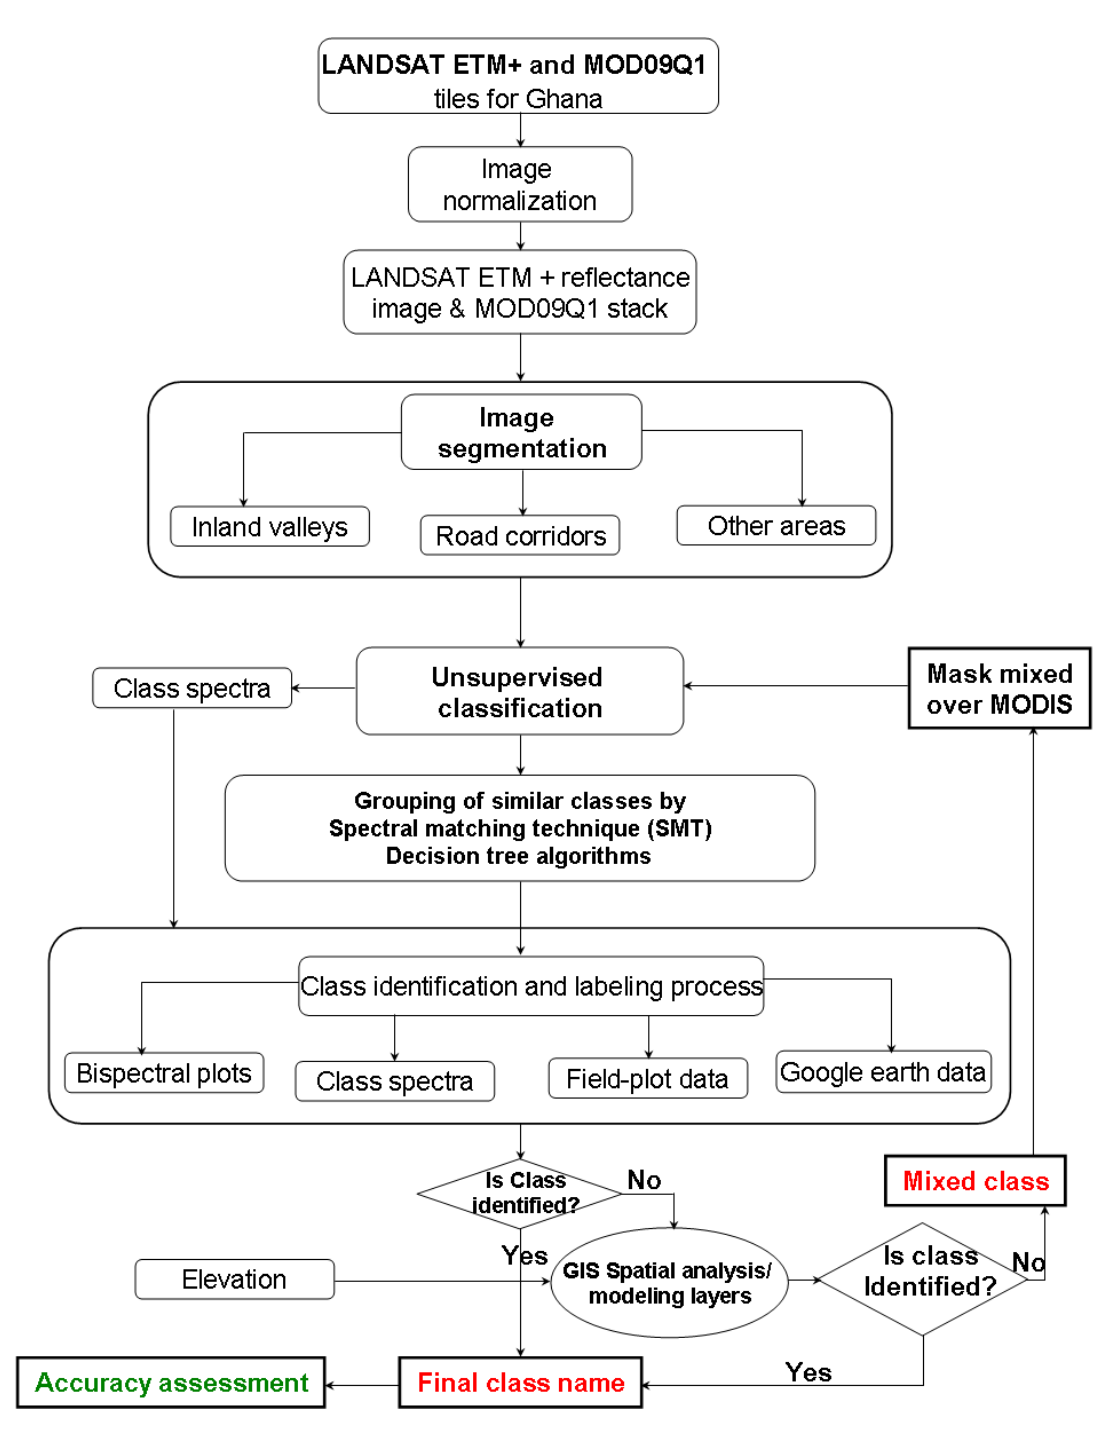
Figure 2. Overview of the methodology for mapping irrigated areas using MODIS